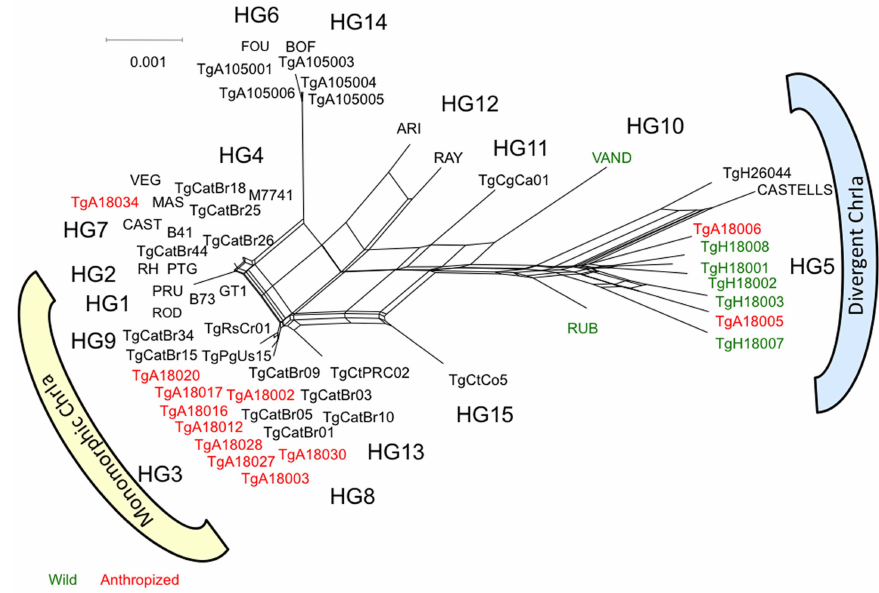
Figure 4. Neighbor-net analysis of genetic diversity on ChrIa. Neighbor net constructed using sequences from 12 reference blocks ( , 800– 900 bp each) of ChrIa from representative strains of T. gondii . A strong separation was evident between strains from anthropized and Neotropical rainforest environments of French Guiana. Isolates from anthropized environment harbored a monomorphic version of ChrIa, whereas rainforest isolates contained divergent forms of ChrIa. Color-coding indicates the region of origin and composition of ChrIa: anthropized environment (red), rainforest environment (green), HG reference strains (black), monomorphic ChrIa (yellow), and divergent ChrIa (blue).